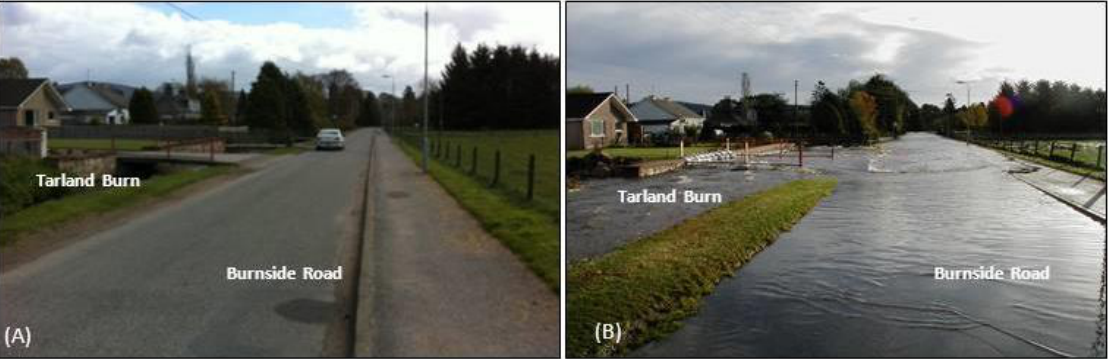
Figure 5. The Burnside Road of Tarland village ( A ) During the normal condition ( B ) During the flood of October 2002 looking